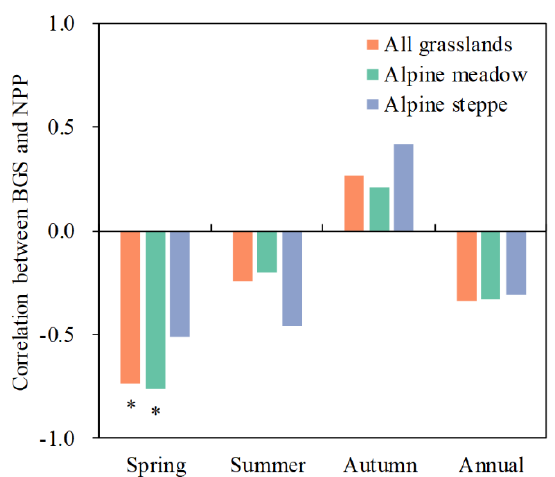
Figure 5. Correlation between beginning of growing season (BGS) and net primary productivity (NPP) in different seasons and the entire year for different biomes. * indicates P < 0.05. Table 2. Areal percentage of significant correlations between beginning of growing season (BGS) and seasonal or annual net primary productivity (NPP), and the ratio of negative correlated area to positive correlated area in different grassland types. Ratio values in bold and in italics indicate ratio of negative correlated area to positive correlated area > 2.0 and < 0.5, respectively.